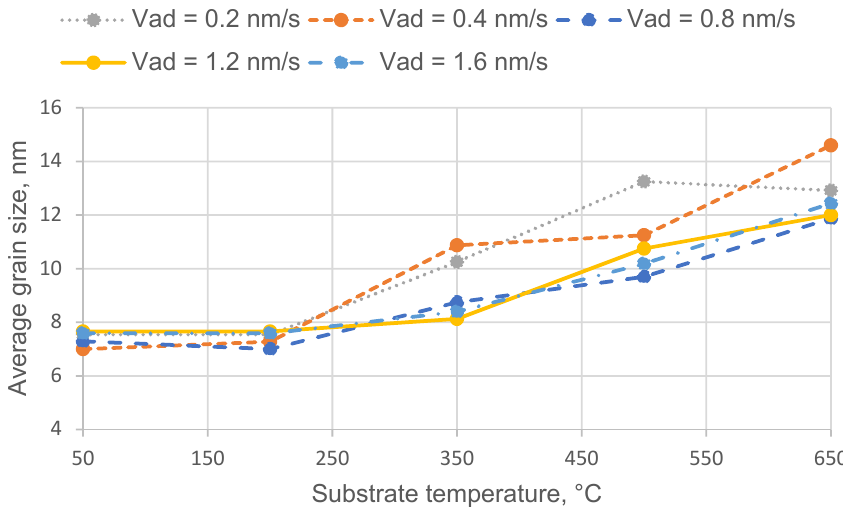
Figure 8. Plots of average grain size versus substrate temperature observed at the growth rates of 0.2, 0.4, 0.8, 1.2, and 1.6 nm/s.